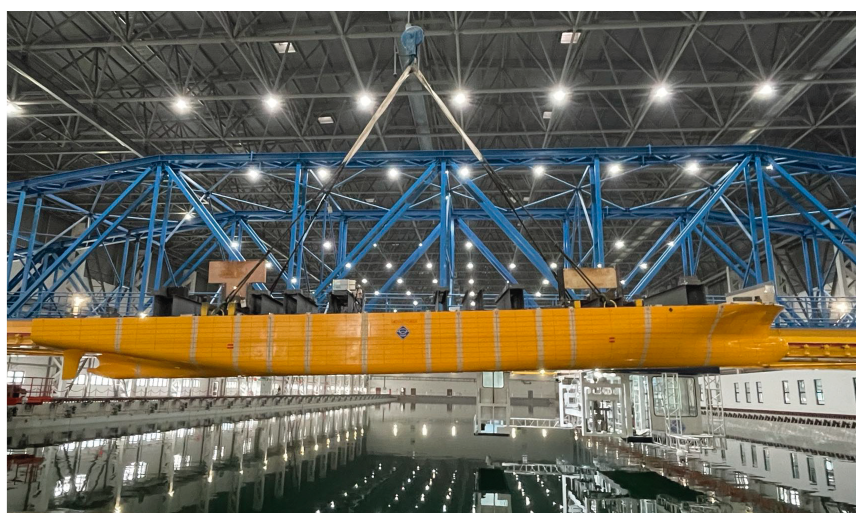
Figure 2: The containership model with 14